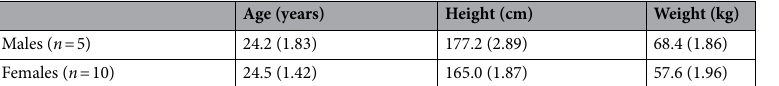
Table 1. Basic demographic information about the male ( n = 5) and female ( n = 10) volunteers. In this study, volunteers were approximately the same age (average age: 24.7, range: 20–29 years) regardless of sex with the males having a higher height and weight. Data is presented as mean (standard error of the